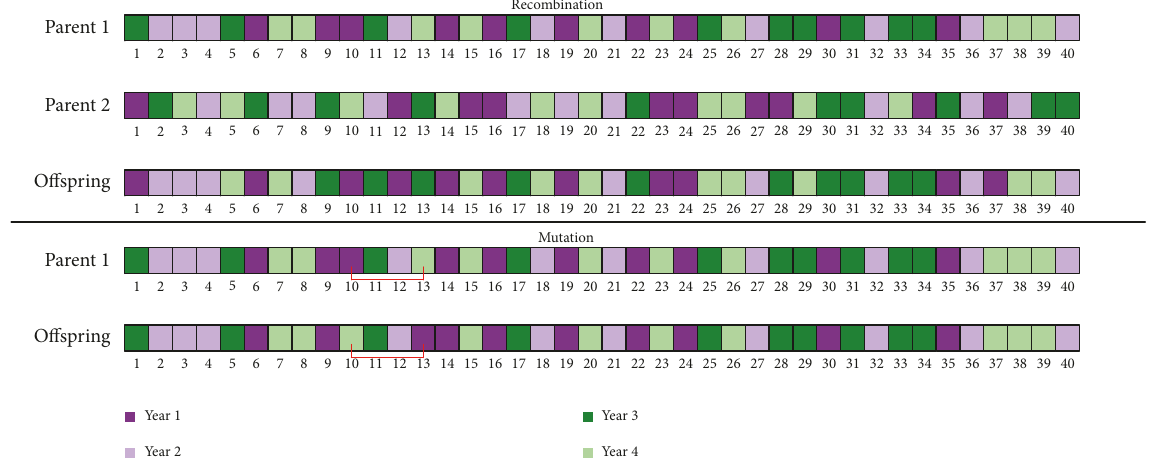
Figure 4: Representation of sample solutions, sorted by unit ID, for 𝑁 = 40 and 𝑛 𝑖 = 10. (Top) Construction of a recombination solution from two randomly selected parent solutions (Bottom) Construction of a mutation solution. The coloring of each unit indicates the time period in which the solution assigns the unit to be used (dark purple = Year 1; light purple = Year 2; dark green = Year 3; and light green = Year